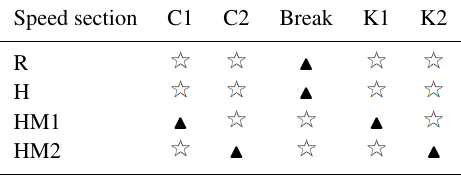
Table 1. Clutch and brake joint site diagram. Speed